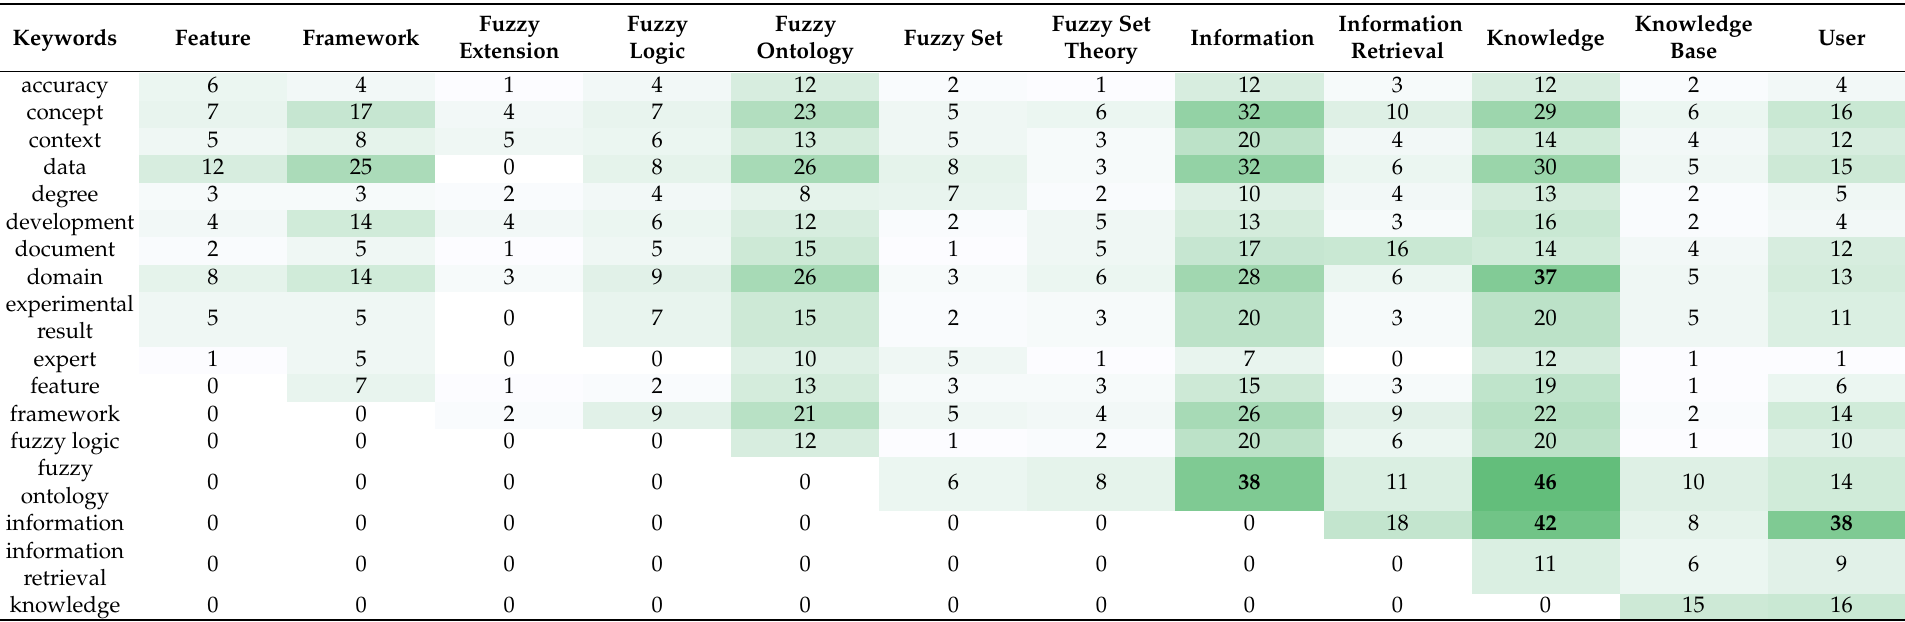
Table 2. The co-occurrence matrix of the most occurring keywords in the ontology- and fuzzy-based IS